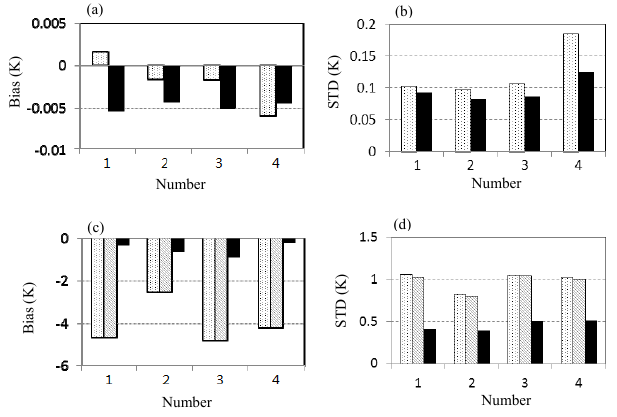
Figure 6. Distribution of the MWTS-2 clear pixels identified by cloud fraction less than 76% (blue dots) over ocean during the pe- riod from 03:00 to 09:00UTC on 1 July 2014. NOAA-18 AMSU-A FOVs with LWP less than 0.03kgm − 2 are shown in grey dots (the FOVs at the scan edge of AMSU-A are in black). The FOVs de- tected by bi-weighting QC are shown in